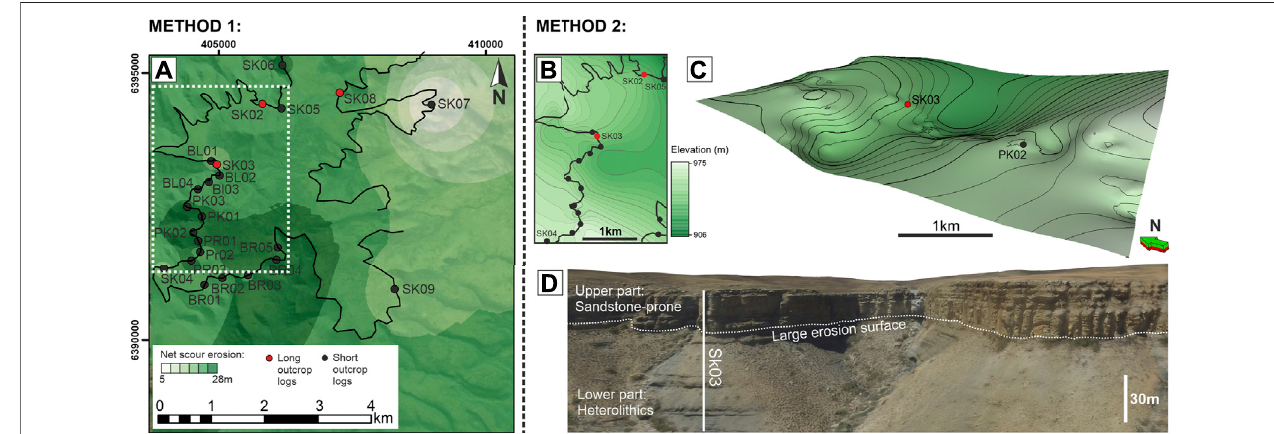
FIGURE8 | Images ofthe erosion surface at the base ofthe upper sandstone-prone part generated using two methods. (A) Method 1: Map of theerosion surface generated by measuring the thickness between the concretion marker bed and the erosion surface, which suggests up to 28 m of erosion. The white dashed box indicates the location of the map in B. (B) Method 2: Detailed map of the erosion surface generated by mapping the surface on photogrammetric models of the outcrop created from Uncrewed Aerial Vehicle imagery. This map shows relative elevation of the erosion surface within the model with darker colours indicating lower elevation andhencemoreerosion,andlightercoloursindicatinghigher elevationsandhencelesserosion.Notethatthetectonictilthasnotbeenremoved. (C) 3Dimage of the erosion surface shown in (B) utilizing the same colour bar. Note the deeper and narrower updip and wider and shallower downdip form. (D) Image of the photogrammetric model of the outcrop at SK03 indicating the erosion surface that was mapped by the dashed white line.